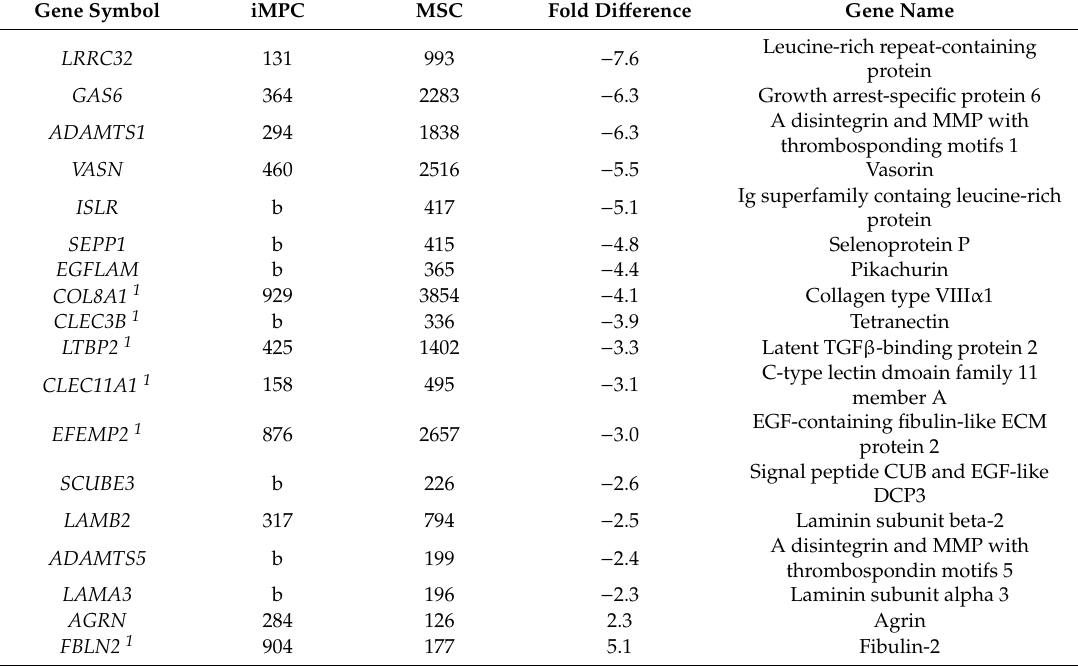
Table 2. The mean microarray expression levels of di ff erentially expressed genes classified as ECM-related according to the Panther algorithm.